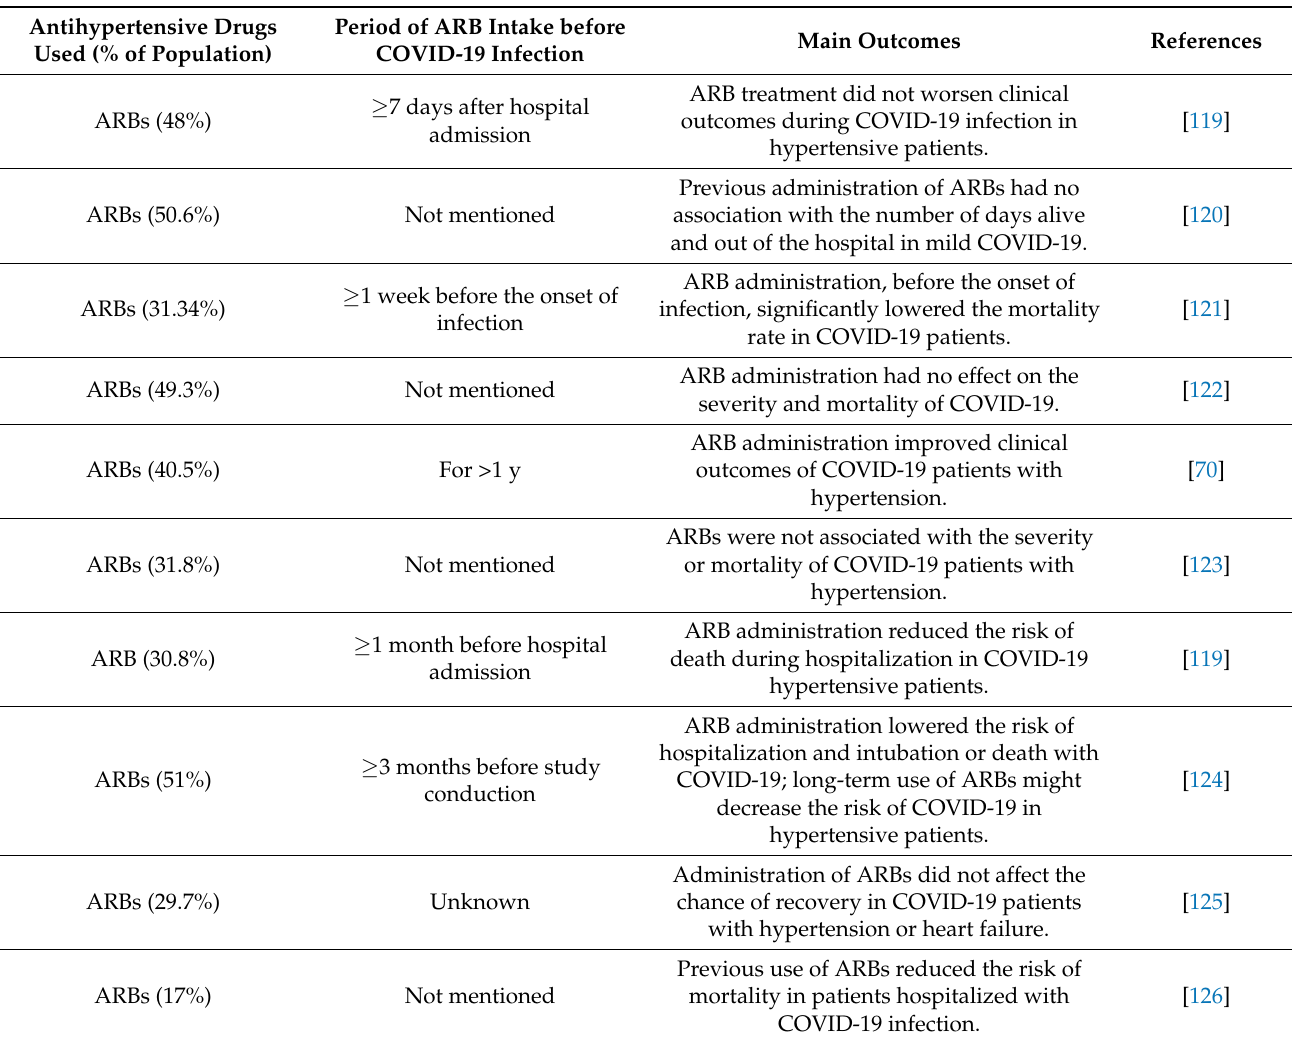
Table 1. Summary of clinical studies and trials associated with hypertension and Ang II type 1 receptor blocker (ARB) administration in relation to COVID-19